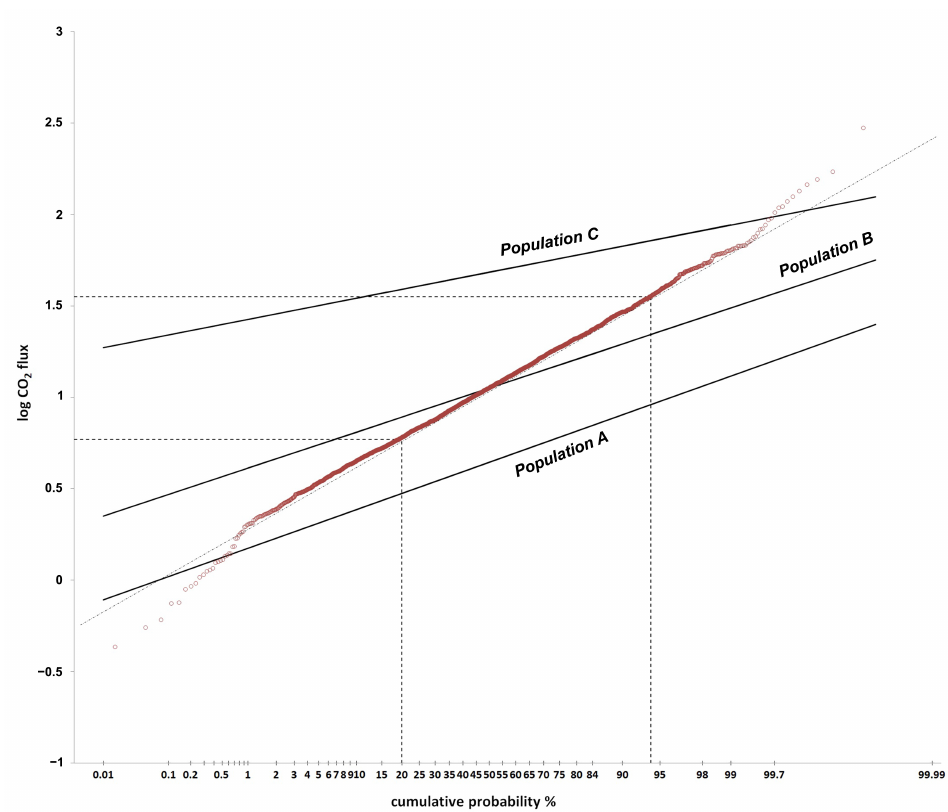
Figure 4. Log-normal probability plot of soil CO 2 flux measurements. The partitioned popula- tions [48] and the inflection points are shown. A dashed straight line traced through the central part of the plot helps visualize the chosen inflection